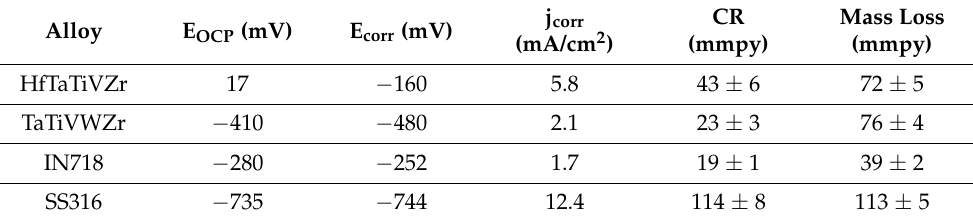
Figure 4. ( a ) Open Circuit Potential (E OCP ) curves of the alloys for 1 h of exposure time and ( b ) potentiodynamic polarization curves in molten FLiNaK salt at 650 ◦ C in an Ar gas atmosphere. Table 2. Summary of potentiodynamic polarization results in FLiNaK salt at 650 ◦ C in Ar gas atmosphere.